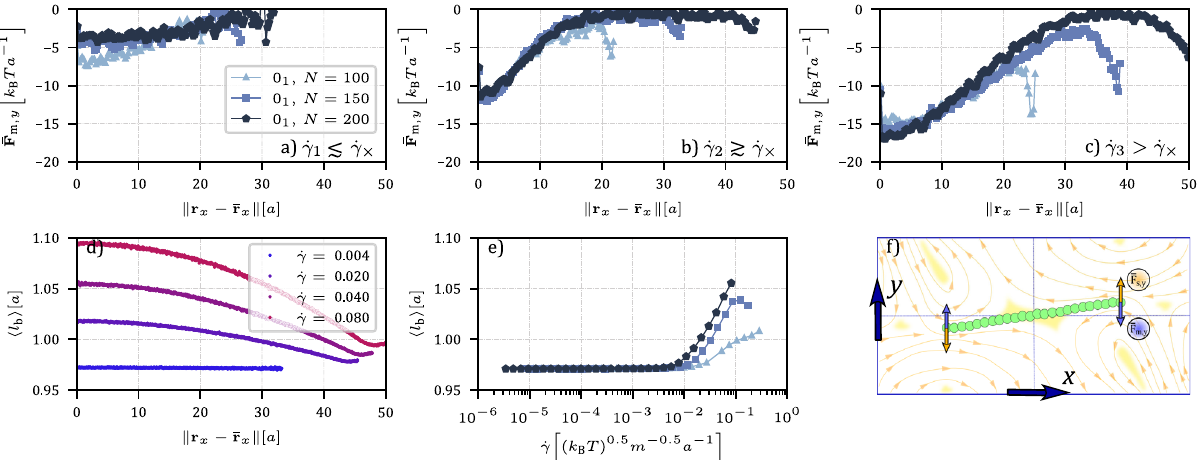
Fig. 4 Inter-monomer forces and bond extension along the ring. a – c Gradient-direction component of force on beads, averaged in intervals along the fl ow axis and measured relative to the centre of mass. A negative sign signi fi es a pull towards the centre of mass. Shear rate increases from ( a ) to ( c ). a At _ γ